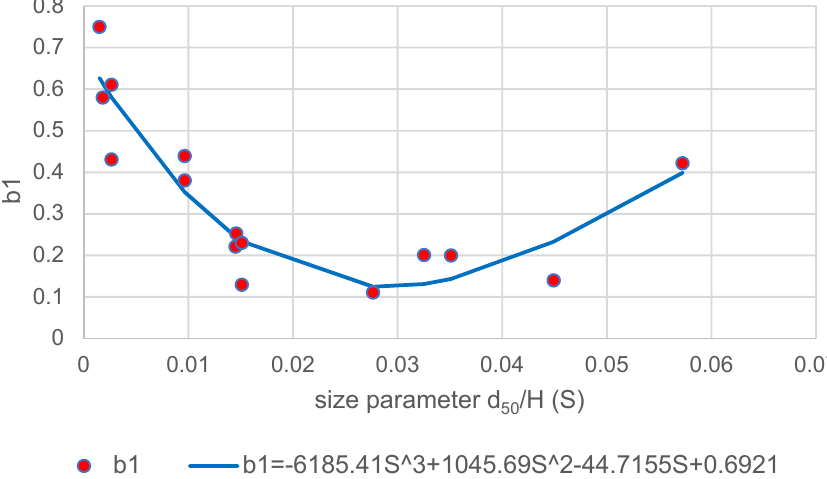
Figure 9. Size parameter vs. coefficient b 1 using decision trees ( R 2 = 0.856).